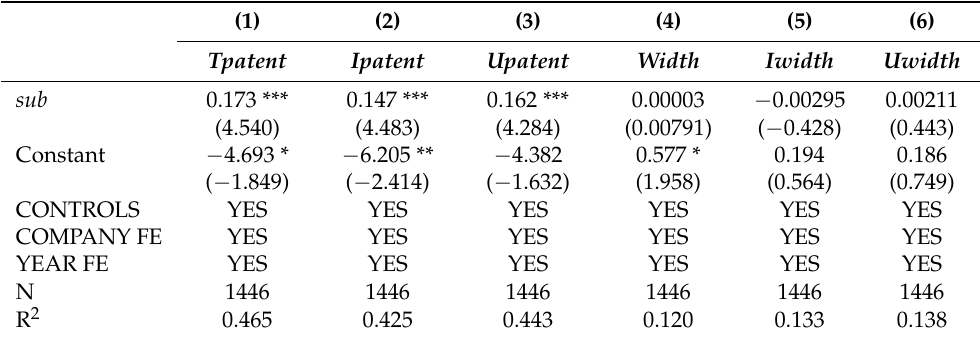
Table 4. The regression results of government subsidies on the quantity and quality of technological